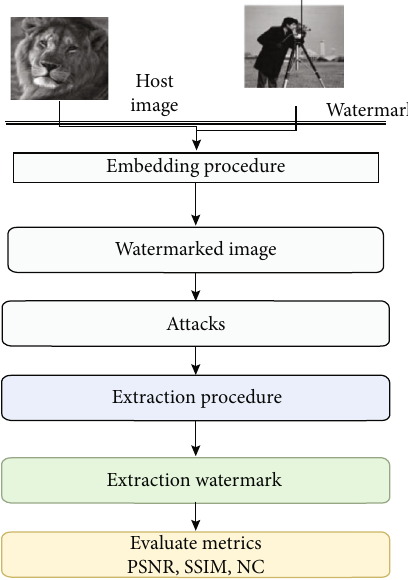
Figure 1: Proposed system.